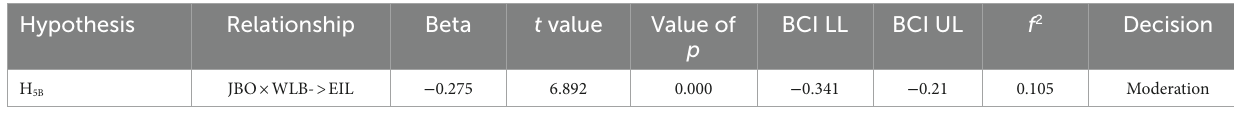
TABLE 6 Moderating